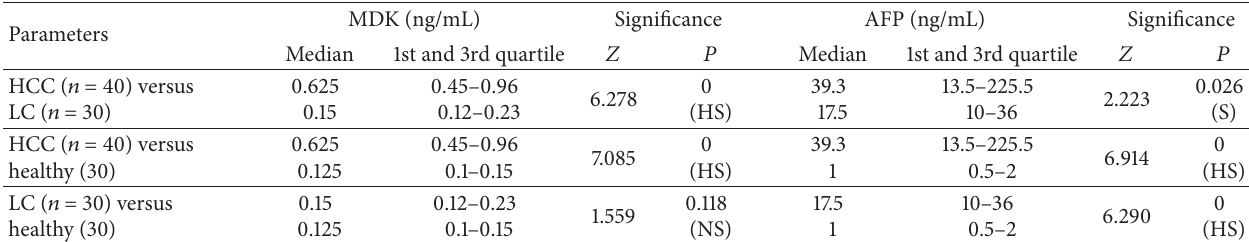
Table 1: Comparison between each of the two studied groups regarding serums AFP and MDK.